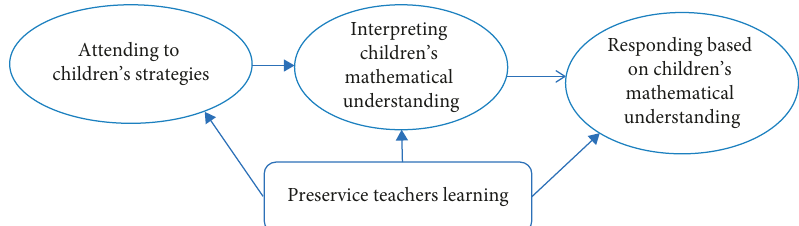
Figure 2: Model for PSTs’ learning of the component skills of professional noticing of Children’s mathematical